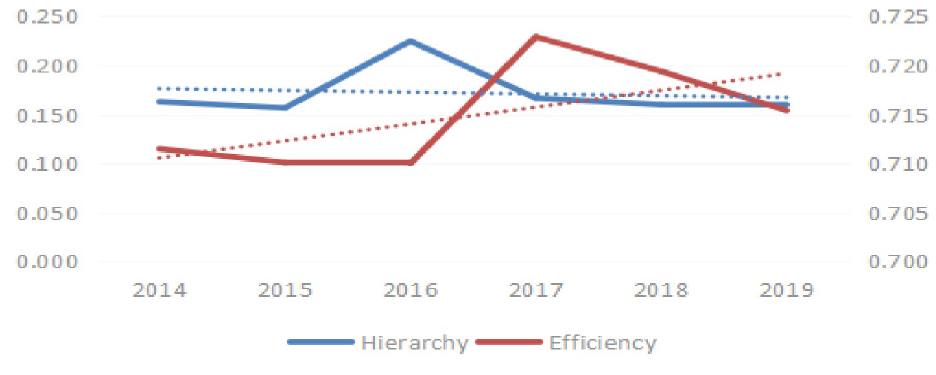
Fig 3. Trends in network hierarchy and network efficiency in China’s new energy vehicle